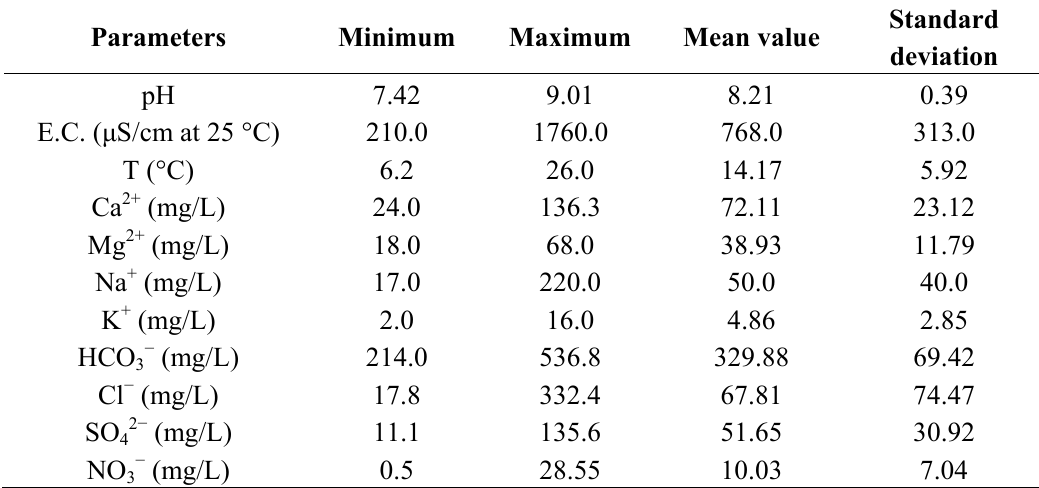
Table 1. Summary statistics for concentrations of surface water